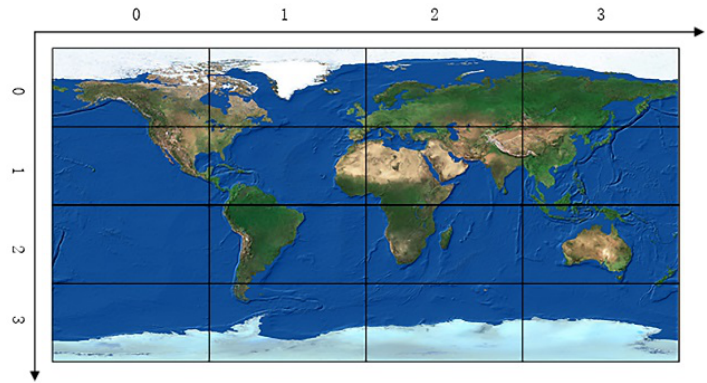
Figure 3. Grid cells ‘representation.